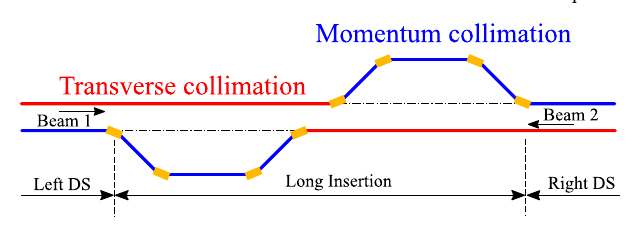
FIG. 1. Layout of the combined transverse and momentum collimation